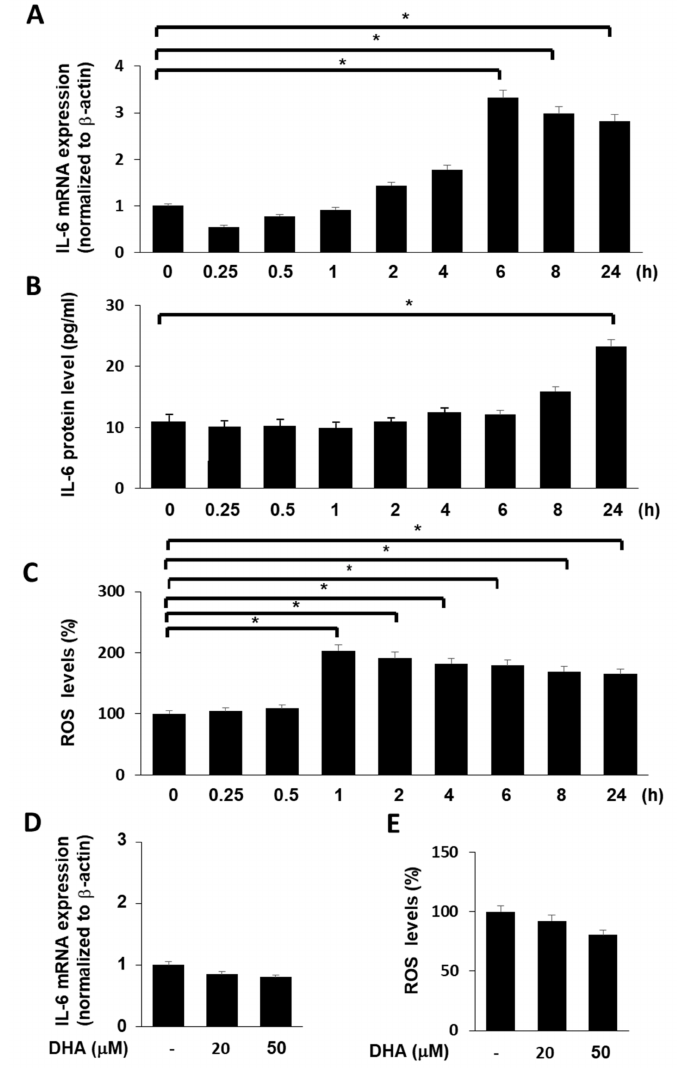
Figure 2. E ff ect of cerulein or DHA on the expression of IL-6 and ROS levels in AR42J cells. ( A ) Cells (2 × 10 5 / well) were stimulated with cerulein (10 − 8 M) for the indicated time periods (0.25, 0.5, 1, 2, 4, 6, 8, and 24 h). IL-6 mRNA expression was determined by real-time PCR analysis and normalized to β -actin mRNA expression. ( B ) Cells (2 × 10 5 / well) were stimulated with cerulein (10 − 8 M) for the indicated time periods (0.25, 0.5, 1, 2, 4, 6, 8, and 24 h). IL-6 concentration in the cell culture medium was determined by ELISA. ( C ) Cells (2 × 10 5 / well) were stimulated with cerulein (10 − 8 M) for the indicated time periods (0.25, 0.5, 1, 2, 4, 6, 8, and 24 h). Then, cells were incubated with 10 µ g / mL dichlorofluorescein diacetate (DCF-DA) for 30 min and washed with PBS. Cellular ROS levels were determined by measuring the level of fluorescent DCF. Intracellular ROS levels are expressed as the relative increase. The value for ROS levels in unstimulated cells (cells without cerulein stimulation) was set at 100%. Data are expressed as the mean ± S.E. of three independent experiments. * p < 0.05. ( D ) Cells (2 × 10 5 / well) were treated with DHA (20 or 50 µ M) for 7 h. IL-6 mRNA expression was determined by real-time PCR analysis and normalized to β -actin mRNA expression. (E) Cells (2 × 10 5 / well) were treated with DHA (20 or 50 µ M) for 2 h. Then, cells were incubated with 10 µ g / mL DCF-DA for 30 min and washed with PBS. Cellular ROS levels were determined by measuring the level of fluorescent DCF. Intracellular ROS levels are expressed as the relative increase. The value for ROS levels in cells in the absence of DHA was set at 100%. Data are expressed as the mean ± S.E. of three independent experiments. * p < 0.05. − , without